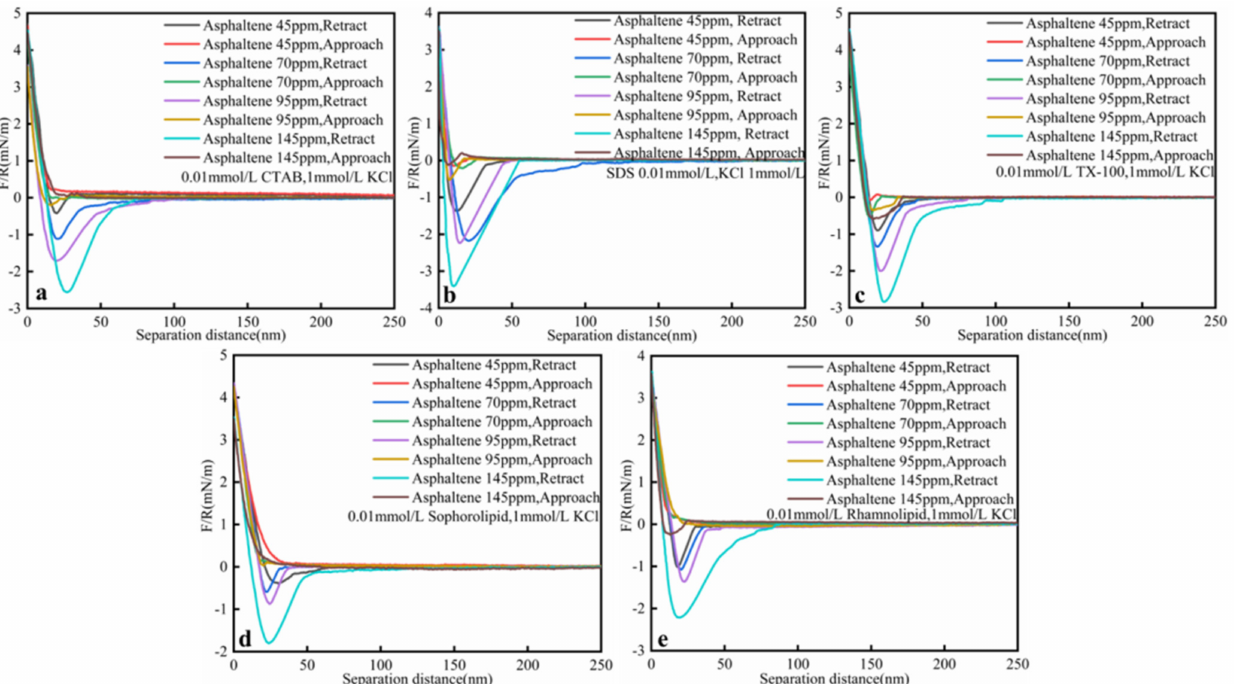
Figure 7. Interaction forces (F/R) between heavy oil and calcium carbonate at different asphaltenes concentration ( a ) CTAB; ( b ) SDS; ( c ) TX-100; ( d ) Sophorolipid; ( e ) Rhamnolipid solutions as a function of the separation distance at ambient conditions (0.01 mmol/L surfactants, 25 ◦ C, 1 mmol/L KCl, pH = 3.5). Table 6. Adhesion forces (F/R) between heavy oil and calcium carbonate in different